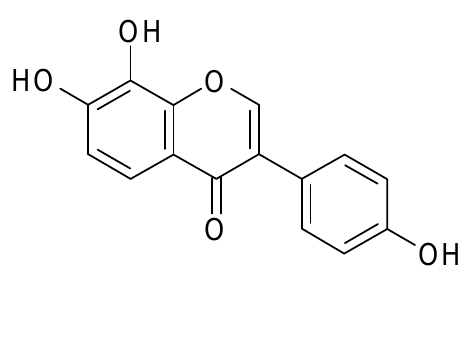
Figure 1. Chemical structure of